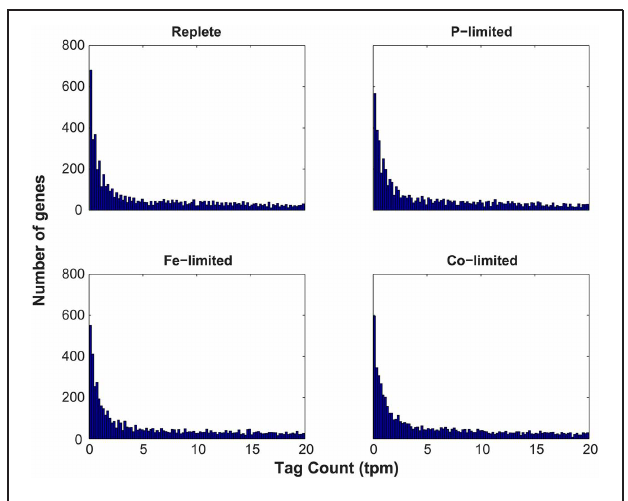
FIGURE A1 | Histogram analysis of the distribution of normalized tag counts (tpm) for each gene across each of the four treatments (Replete, P-limited, Fe-limited, and Co-limited). The abundance of normalized tag counts (tpm) was assessed, tallying the total number of genes with a given tag count. Only tag counts less than 20 are depicted to aid the visualization of the inflection in the data at 2.5tpm.